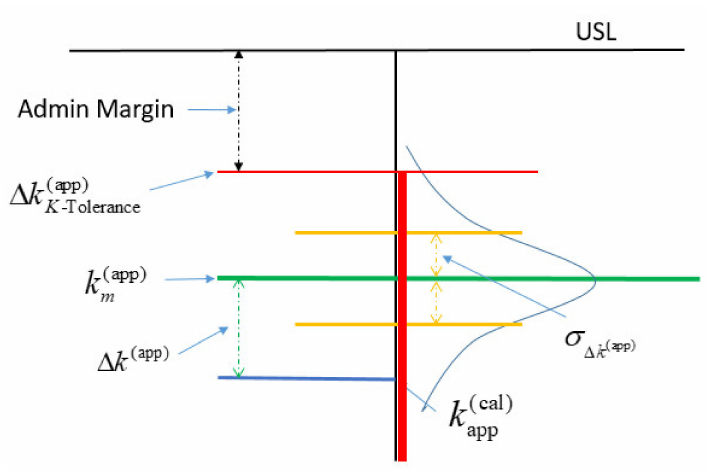
Figure 1. Relationship of USL and TSURFER Bias Tolerance Limit. The reference value for k eff prior to the application of TSURFER is marked by the blue ( cal ) ( app ) calculated by TSURFER is marked by the double- horizontal line k app . The bias k pointing arrow, bringing the best-estimate of k eff to the green line. Since the TSURFER methodology is statistical, the confidence in the bias estimate is described by an epistemic PDF, as marked by the blue curve. This PDF is assumed to be normal in the TSURFER methodology. The standard deviation σ of this PDF is calculated by TSURFER, ∆ k ( app ) as marked by the two double-pointing orange arrows around the best-estimate adjusted value. The upper threshold of the tolerance interval is marked by the red line, so the area underneath the PDF is at least 0.95, implying with 95% confidence that the true value for the bias will ensure a k eff value below the upper threshold limit. The interval upper-limited by the red line (marked by a solid red bar) is the tolerance interval for TSURFER’s bias. Finally, an additional administrative margin is added to reach the USL